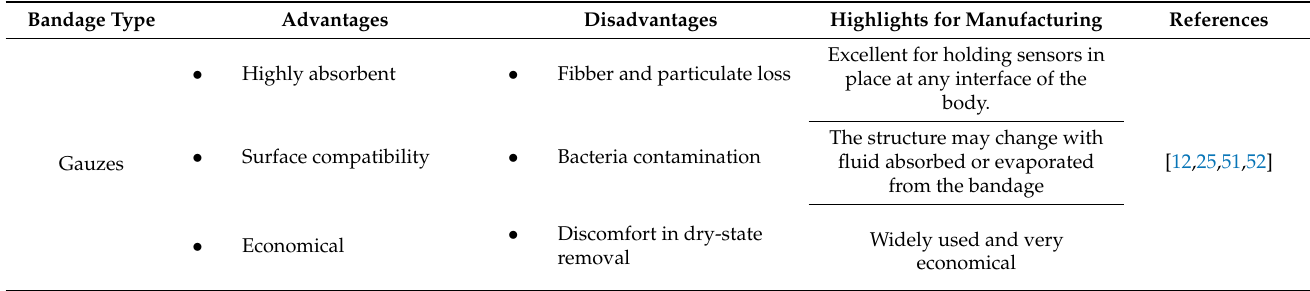
Table 1. Advantages and disadvantages of the main bandages on the market.